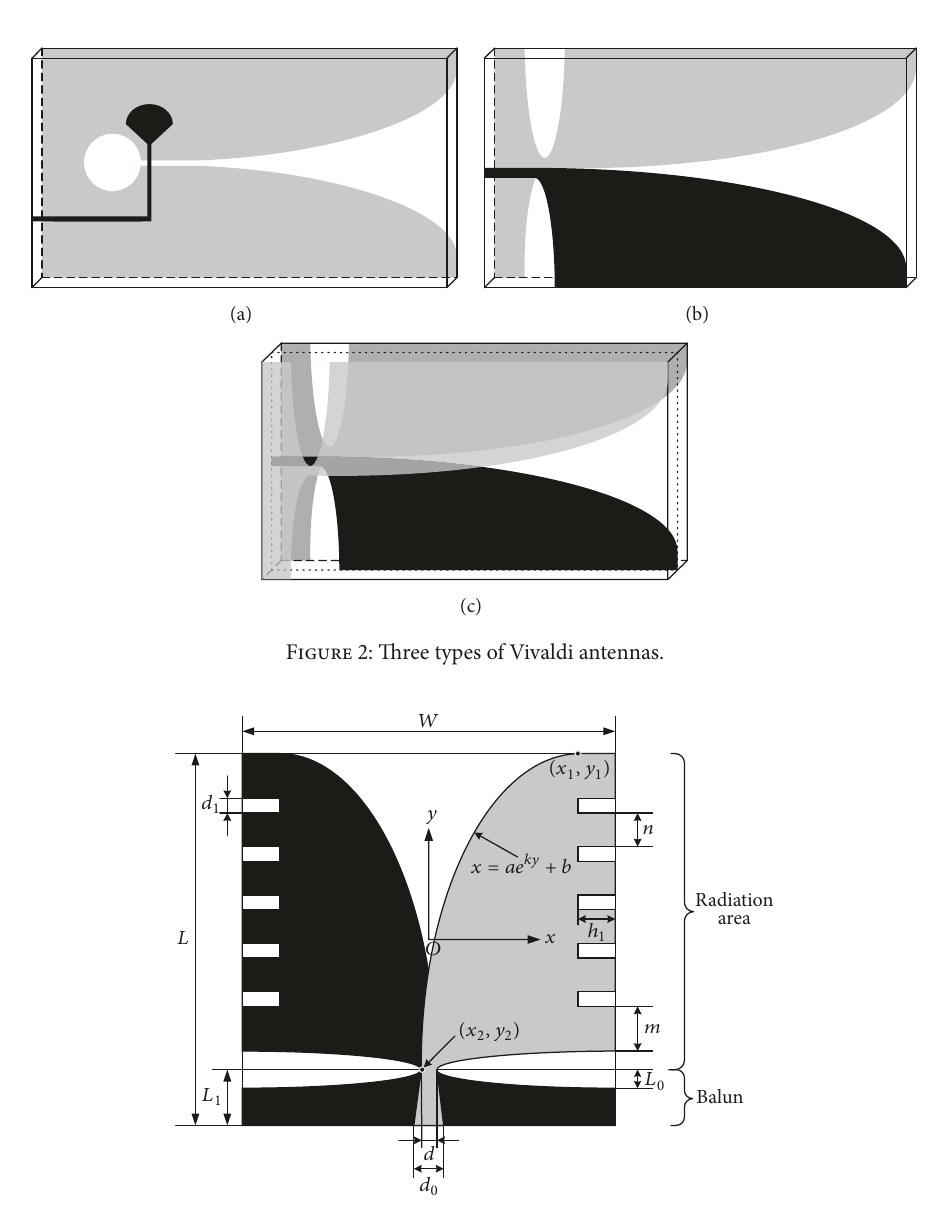
Figure 3: Antipodal Vivaldi